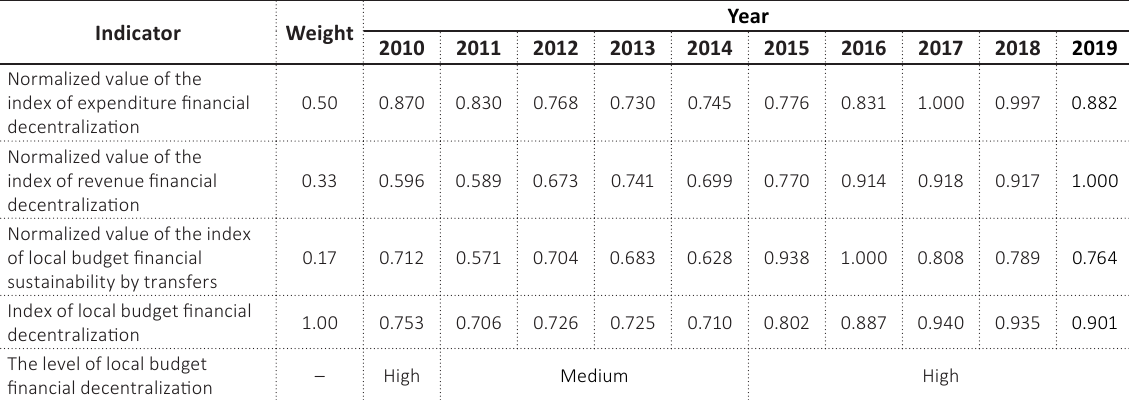
Table 2. The level of local budget financial decentralization in Ukraine for 2010–2019, %